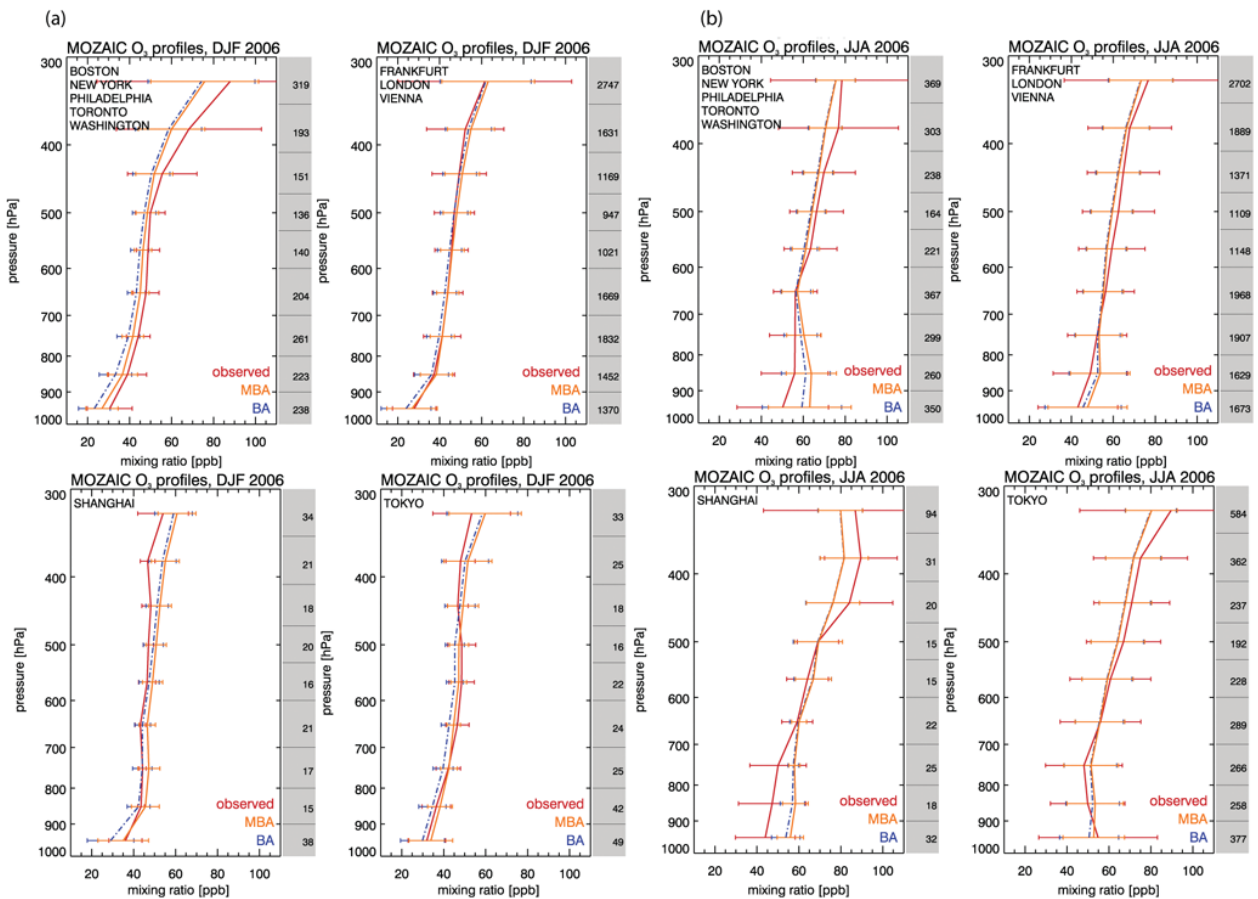
Fig. 6. (a) Comparisons of the vertical distributions of tropospheric ozone measured during take-off and landing as part of MOZAIC for season DJF during 2006. Regional comparisons are shown for (from top left to bottom right) the Eastern US (Atlanta; 33.6 ◦ N, 84.4 ◦ W; Boston; 42.4 ◦ N, 71.0 ◦ W; Charlotte; 35.2 ◦ N, 80.9 ◦ W; New York; 40.6 ◦ N, 73.8 ◦ W; and Washington; 39.9 ◦ N, 77.5 ◦ W), Europe (Frank- furt; 50.0 ◦ N, 8.5 ◦ E; London; 51.2 ◦ N, 0.2 ◦ W; Vienna; 48.1 ◦ N, 16.6 ◦ E), China (Shanghai; 31.2 ◦ N, 121.3 ◦ E) and Japan (Tokyo; 35.8 ◦ N, 140.4 ◦ E). The number of measurements included in each vertical bin is shown in the grey bar on the right of each plot. (b) As for (a) except for season JJA during